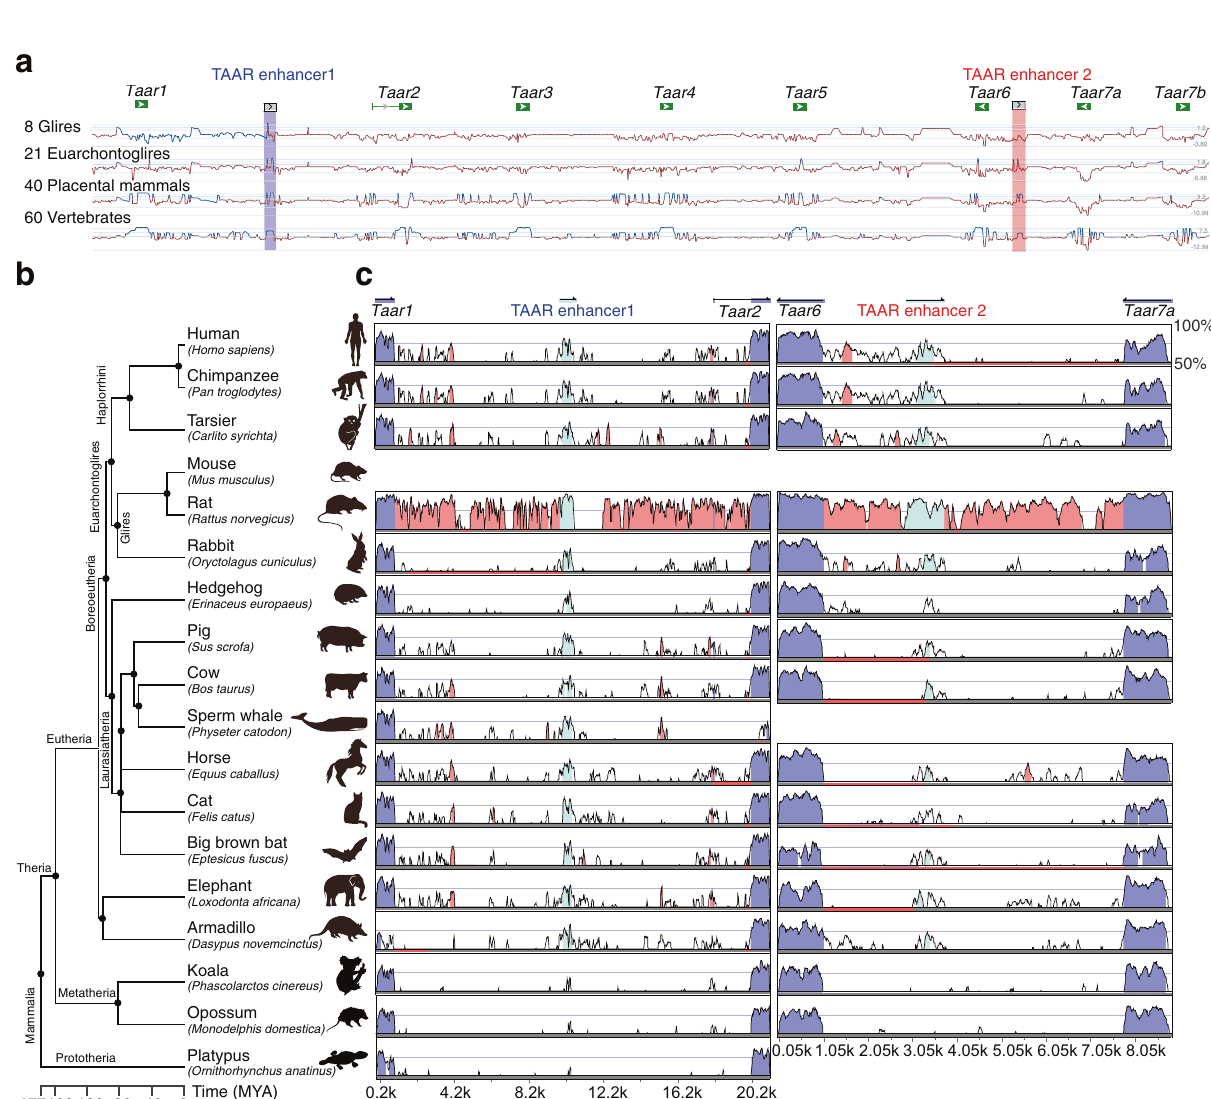
Fig. 3 Evolutionary conservation of the two TAAR enhancers. a Conservation of the Taar cluster ranging from Taar1 to Taar7b in mouse with that in 8 Glires, 21 Euarchontoglires, 40 placental mammals, and 60 vertebrates using phyloP methods. Sites predicted to be conserved were assigned positive scores and shown in blue. Peaks represent the conserved regions. b Phylogenetic tree of representative species selected from Eutheria, Metatheria, and Prototheria order. Each branch length was calculated from divergence times obtained from TimeTree. MYA million years ago. c Nucleotide percent identity plots of TAAR enhancer 1 (left) and TAAR enhancer 2 (right) sequences from different mammals compared to corresponding mouse sequences using VISTA. The arrows indicate the transcriptional orientations of Taar genes in mouse genome. Conservation between 50 and 100% are shown as peaks. Highly conserved regions (>100 bp width and >70% identity) in exons, intergenic regions, and TAAR enhancers are shown in blue, red, and cyan,